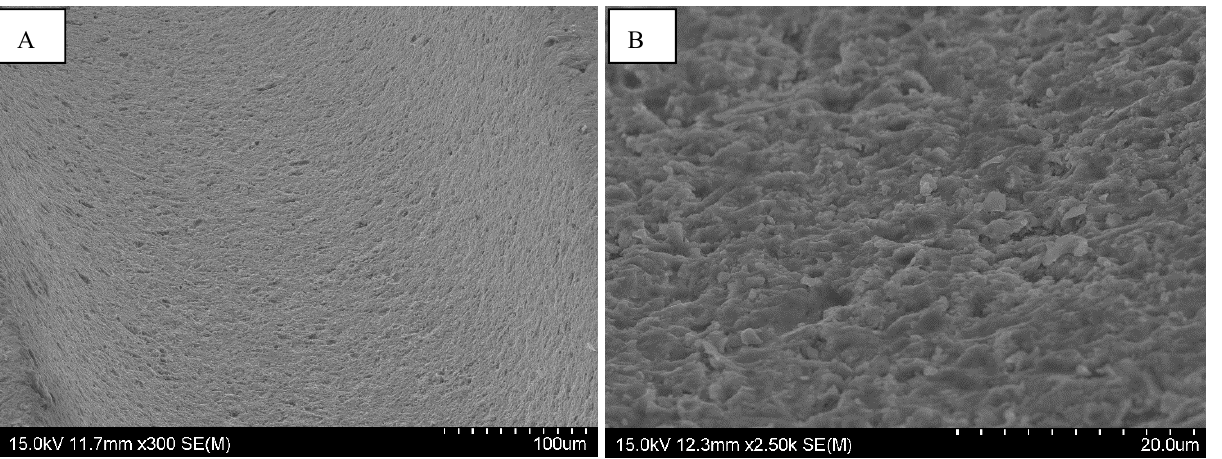
Figure 3. SEM images of the Axiom ® implant surface morphology from Anthogyr ( A ); Natea ® from Euroteknika ( B ) and Idcam ® IDI System ( C ) showing irengular surfaces: magnification ×300.